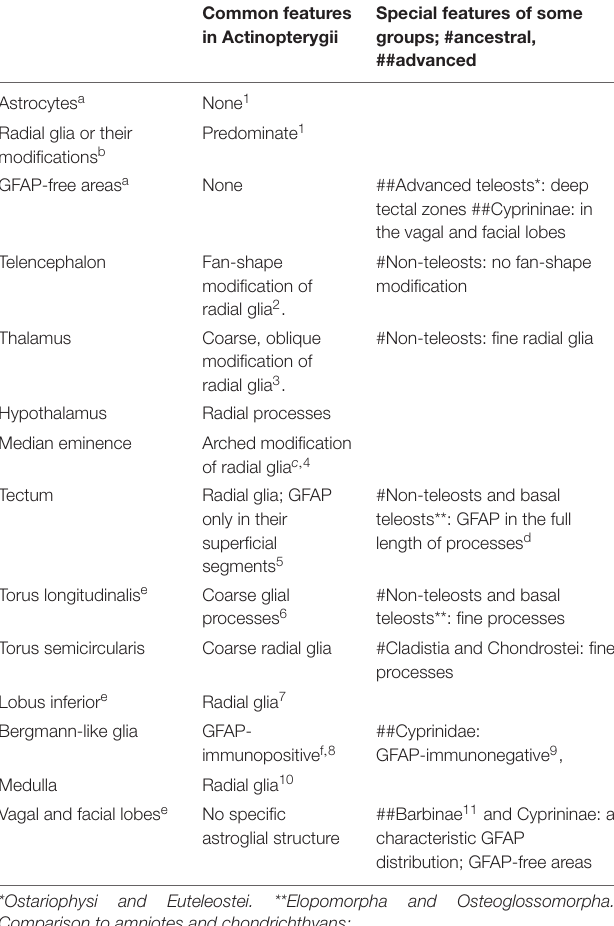
TABLE 1 | The summary of results with the most important supporting citations. Common features Special features of some in Actinopterygii groups;